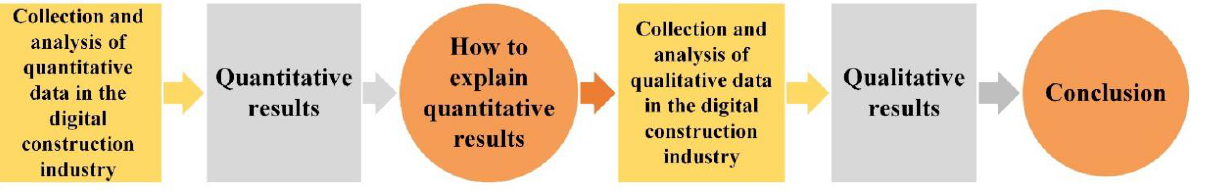
Figure 3. Flowchart of explanatory sequence design.